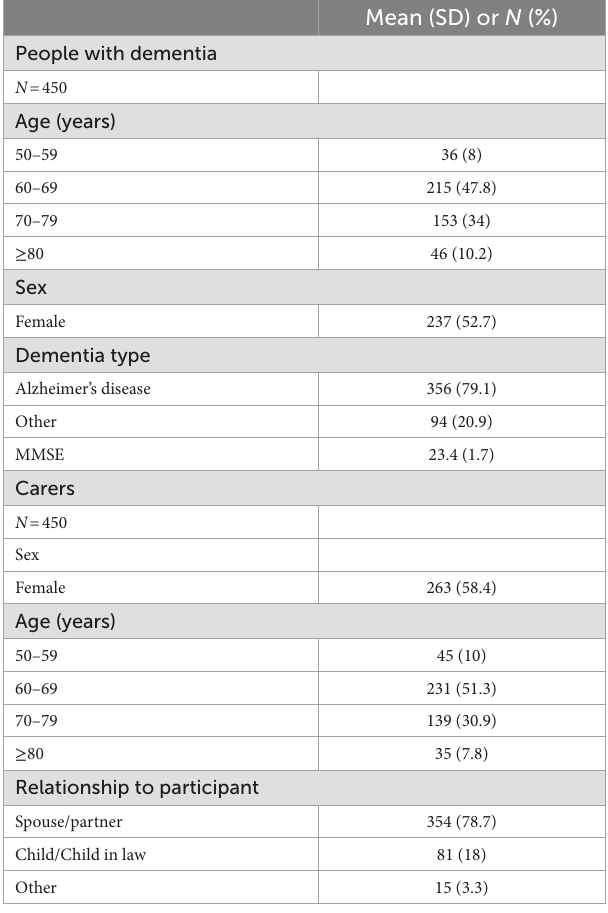
TABLE 1 Demographics of people with dementia and family carers ( N =